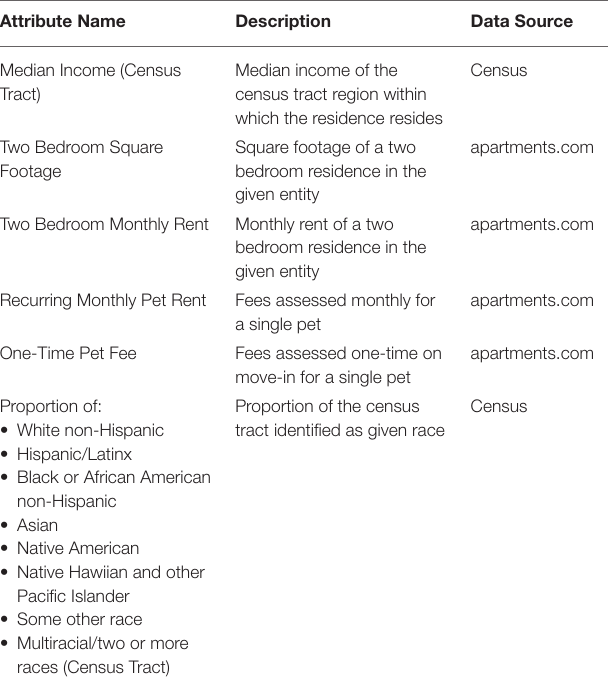
TABLE 1 | Lists the cities, their population, and the number of samples from each in this dataset.